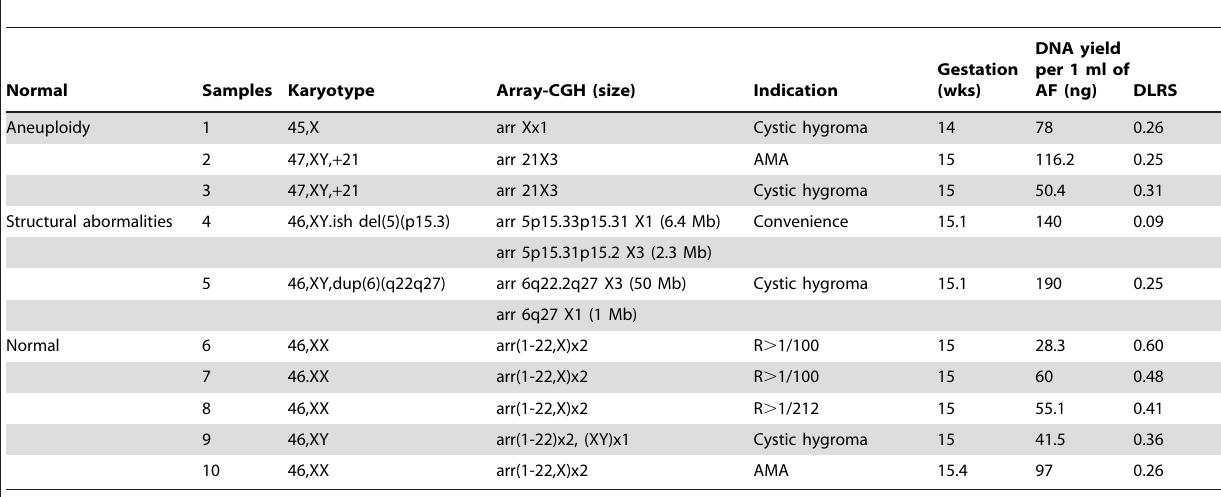
Table 1. Summary of karyotype, array-CGH results, indication and DNA isolated from 1 ml of uncultured amniotic fluid at less than 16 weeks’